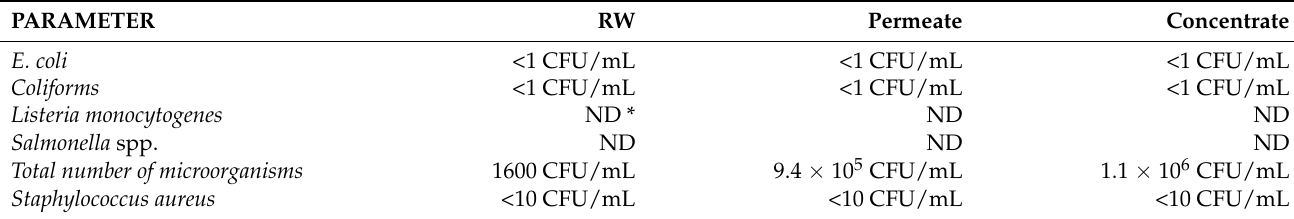
Table 6. Microbiological analyses after